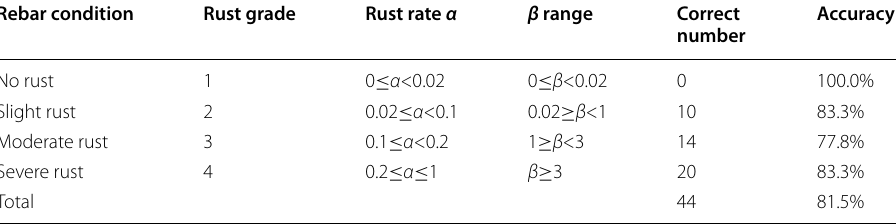
Table 7 Accuracy of model NBC-I